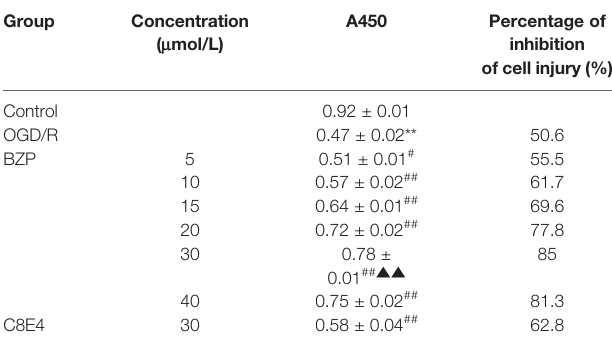
TABLE 5 | The Cell Viability of OGD/R induced PC12 cells injury. Group